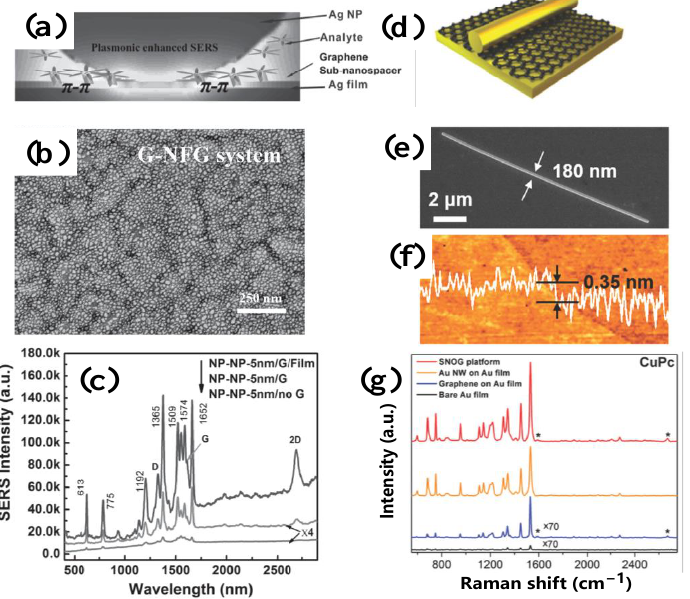
Figure 3. ( a ) The scheme of Ag NPs/graphene/Ag film structure. ( b ) The SEM image of Ag NPs/graphene/Ag film structure. ( c ) The SERS spectra of R6G molecules on Ag NPS/graphene/Ag film, Ag NPs/graphene, and Ag NPs. Reprinted from Ref. [76] with permission of 2014 Wiley Online Library. ( d ) The scheme of Au NW/Au film structure. ( e ) The SEM image of Au NW/Au film structure. ( f ) The AFM image of Au NW/Au film structure. ( g ) The SERS spectra of CuPc molecules on single Au NW/graphene/Au film (SNOG), Au NW/Au film, graphene/Au film, and Au film, respectively. The asterisk-marked peaks denote G and 2D bands of graphene. Reprinted from Ref. [77] with permission of 2016 Royal Society of